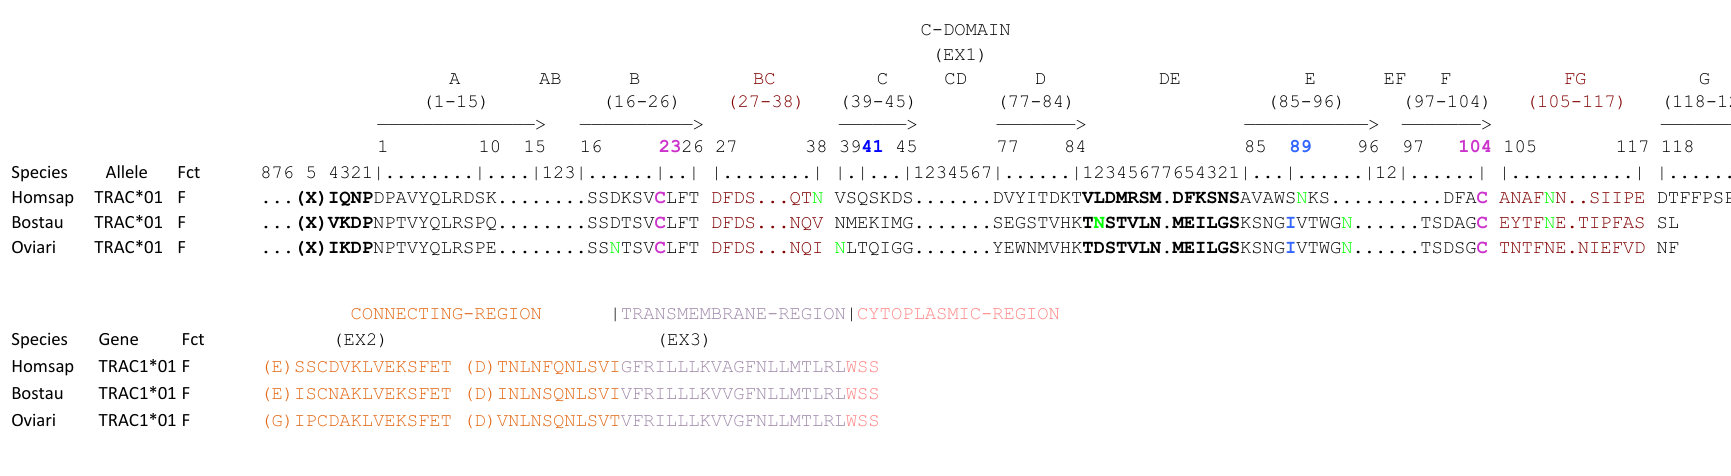
Figure 2. Protein display of the TRAC genes in human (Homsap), bovine (Bostau) and sheep (Oviari). Only alleles *01 are shown. The description of the strands and loops is according to the IMGT unique numbering for C-DOMAIN [29]. The AA between parentheses at the beginning of EX1, EX2 and EX3 corresponds to the first codon resulting from a splicing frame 1 (sf1). (http://www.imgt.org/IMGTeducation/Aide-memoire/_UK/splicing/). Data available in IMGT Repertoire (IG and TR) http://www.imgt.org/IMGTrepertoire/ > Proteins and alleles > Protein displays > C-DOMAIN > TRAC > Human, ibid. Bovine, ibid.